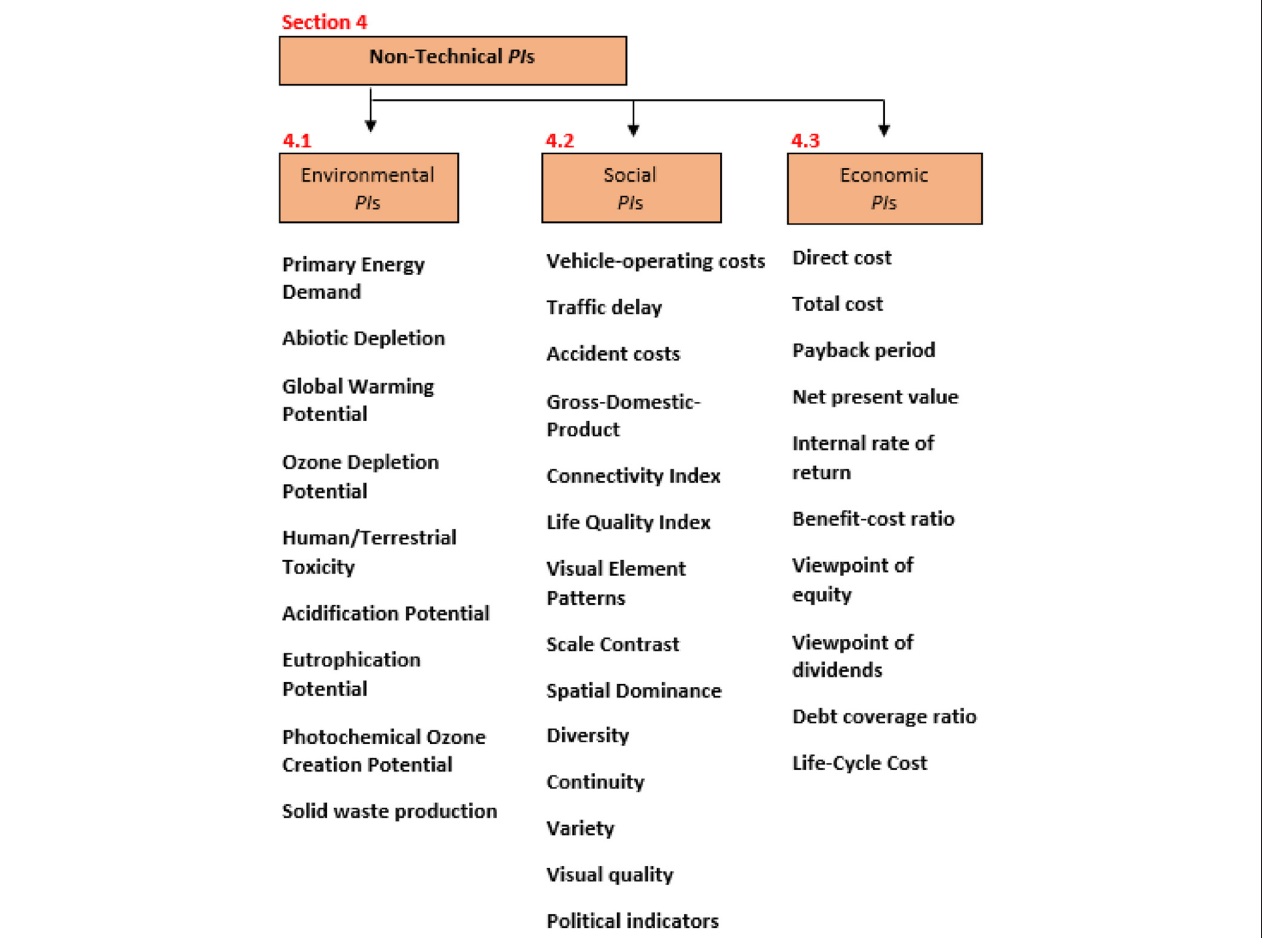
FIGURE 4 | Sketch of the investigated non-technical PI s.